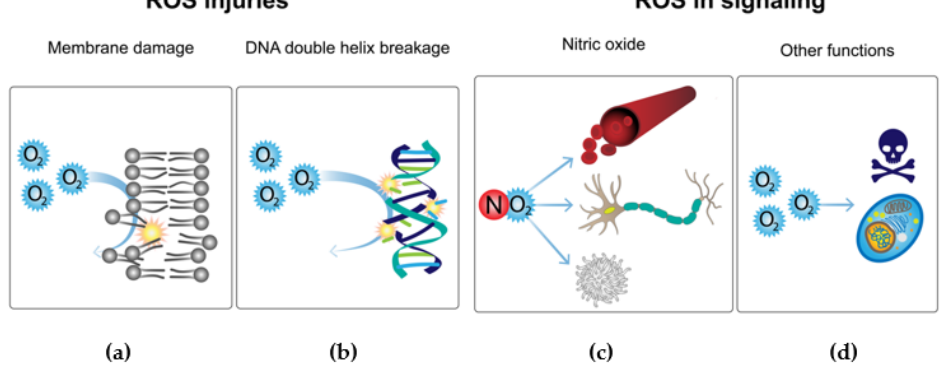
Figure 7. Toxic ROS effects and implementation in signaling pathways. Comparison of the damaging effects of reactive oxygen species and their current implementation in oxygen metabolism. ( a ) Reactive oxygen species (ROS) can have highly toxic effects on living beings, one of the most harmful being the damage to cellular membranes by lipid peroxidation [79]. ( b ) ROS also can attack DNA, resulting in strand breaks [79]. ( c ) Nitric oxide plays an important role in the regulation of several cellular functions [79]. ( d ) ROS contribute to the intracellular signaling of tumor necrosis factor ‐α [79]. Eukaryotes adapt the use of ROS as a defense mechanism against pathogenic bacteria; for instance, phagocytes produce ROS by the activation of NADPH oxidase (Figure 7d) [80]. However, in evolution and the constant race of adaptations, bacteria have implemented mechanisms that protect them against the eukaryotic antimicrobial system. These responses consist of the activation of transcriptional factors such as OxyR, PerR, and SoxRS, which are responsible for activating the antioxidant defense system. In this response, the activation of key enzymes such as catalase, thioredoxins, glutathione reductases, ferric uptake regulator, and superoxide dismutases is necessary [80]. pathways that use ROS as key elements in eukaryote signaling. For instance, nitric oxide